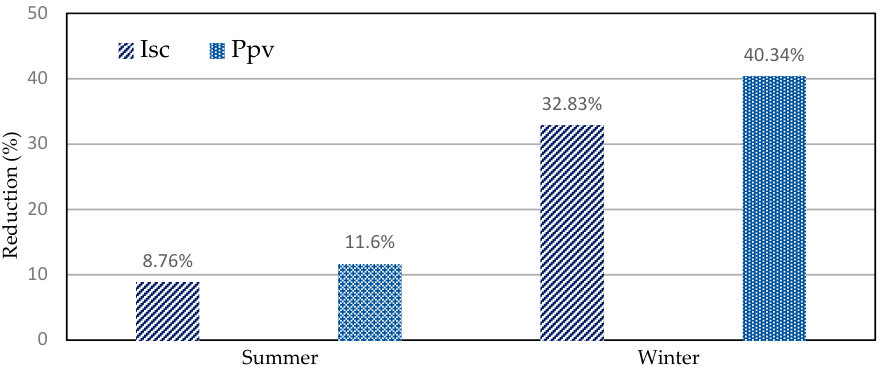
Figure 14. Power output and I SC reduction due to summer and winter seasons and solar incidence angle. It is shown that output power and I SC is reduced by 11.6% and 8.76% in summer and 40.34% and 32.83% in winter, respectively. Obviously, the most reductions of output power and short-circuit current occur in winter that is significant for a small (260 W)